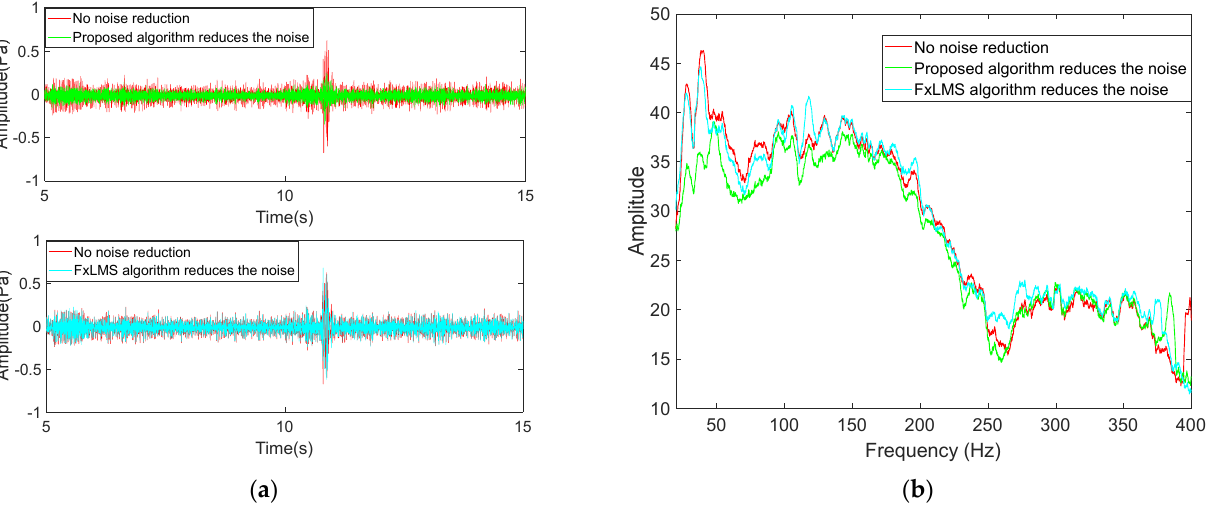
Figure 14. Experimental noise reduction effect at 30 km/h over a speed bump. ( a ) The time domain, ( b ) The frequency domain.